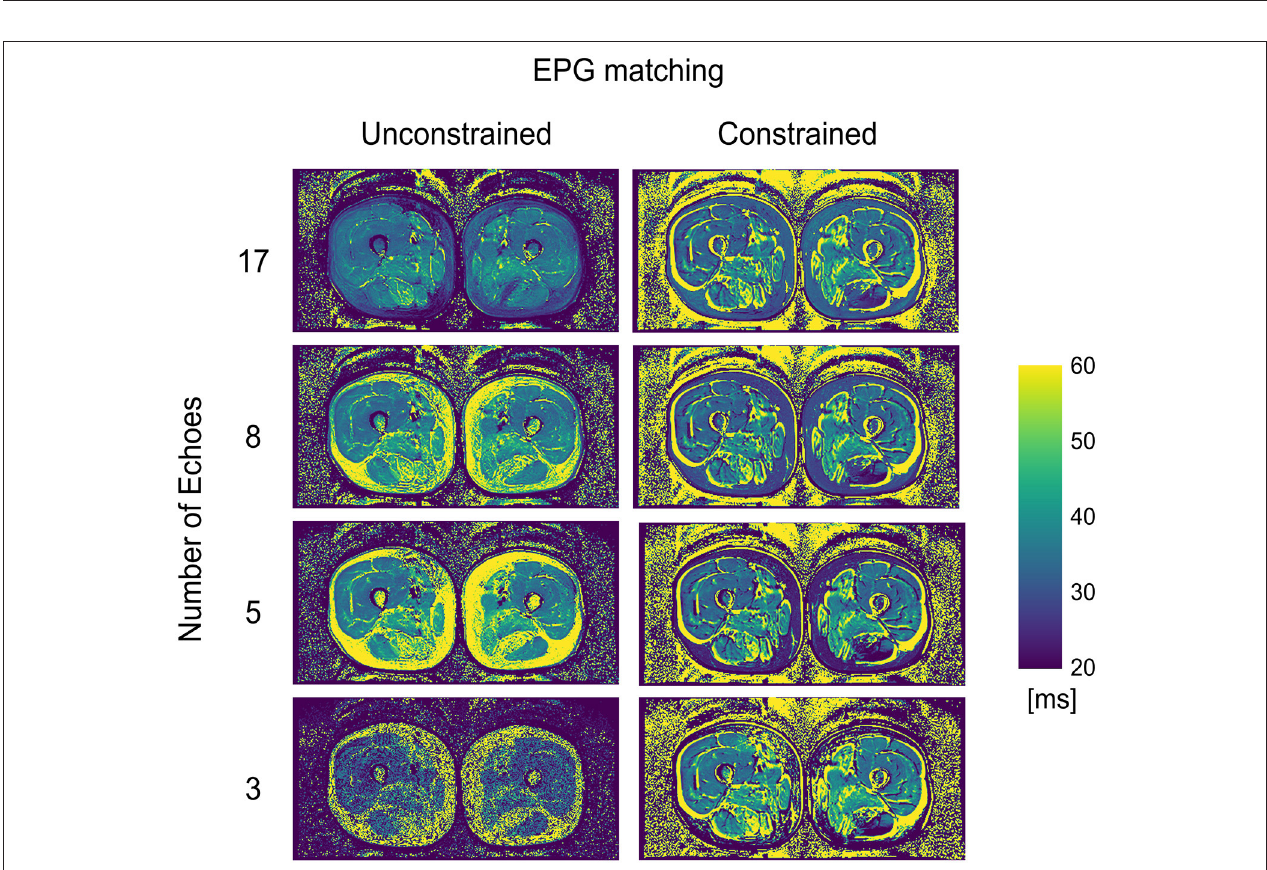
FIGURE 2 | wT2 maps for an FSHD patient using a varying number of acquired echoes by EPG simulation with and without an external fat fraction map as a reconstruction constraint.